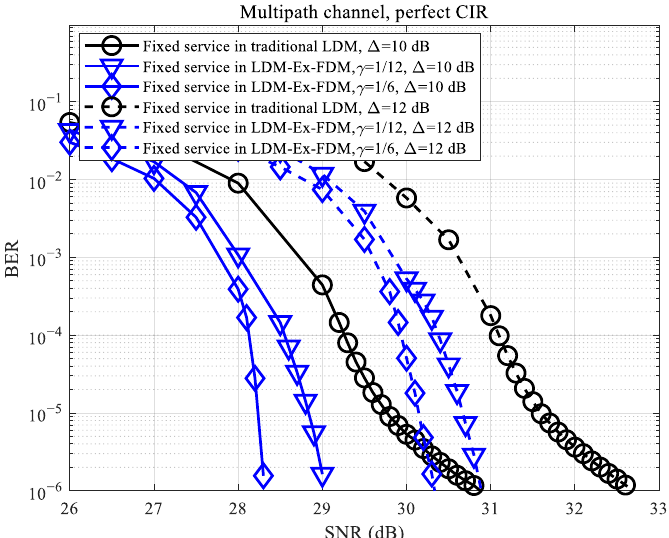
Figure 15. BER performance of fixed service in ATSC 3.0 system with and without LDM-Ex-FDM scheme with perfect channel impulse response (CIR) under the multipath channel, where the pa- rameters of the ATSC 3.0 system were set to ∆ = 10 and 12 dB, the CL constellation was set to QPSK, the EL constellation was set to NU−64QAM, and the puncturing rate of the LDM-Ex-FDM scheme were set to 1/6 and 1/12.